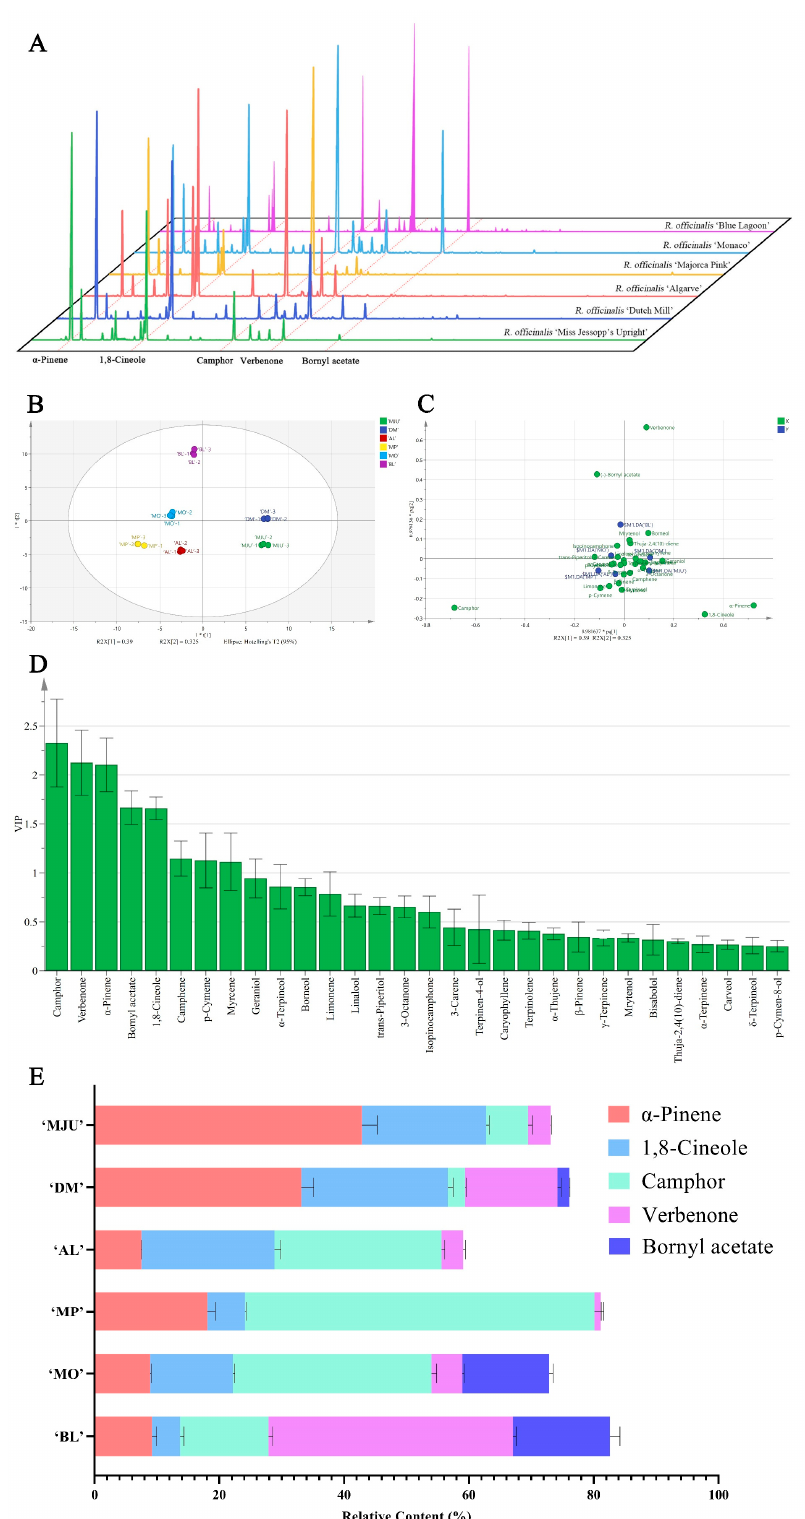
Figure 1. The analysis of chemical composition difference of REOs. ( A ) The chromatograms. ( B ) The scores plot summarizing the relationship among the REOs in the OPLS-DA model. ( C ) The loadings plot summarizing the relationship among the constituents in the OPLS-DA model. ( D ) The VIP plot summarizing the importance of the EO constituents both to explain X and to correlate Y in the OPLS-DA model. ( E ) The main chemical composition of